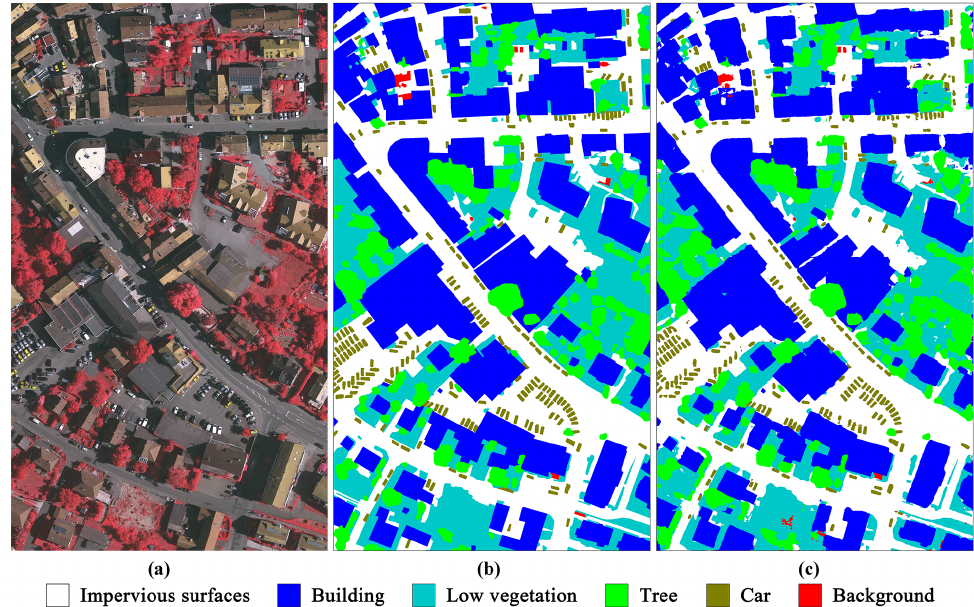
Figure 5. The segmentation result of XANet on the Vaihingen dataset: ( a ) Image; ( b ) Ground truth; and ( c ) Segmentation result.